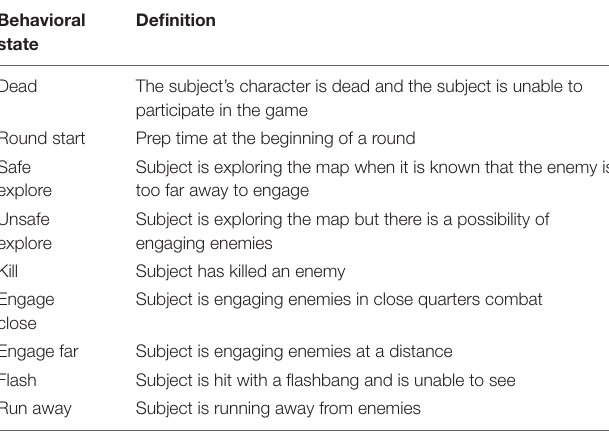
TABLE 1 | Descriptions of the nine behavioral states in the video game